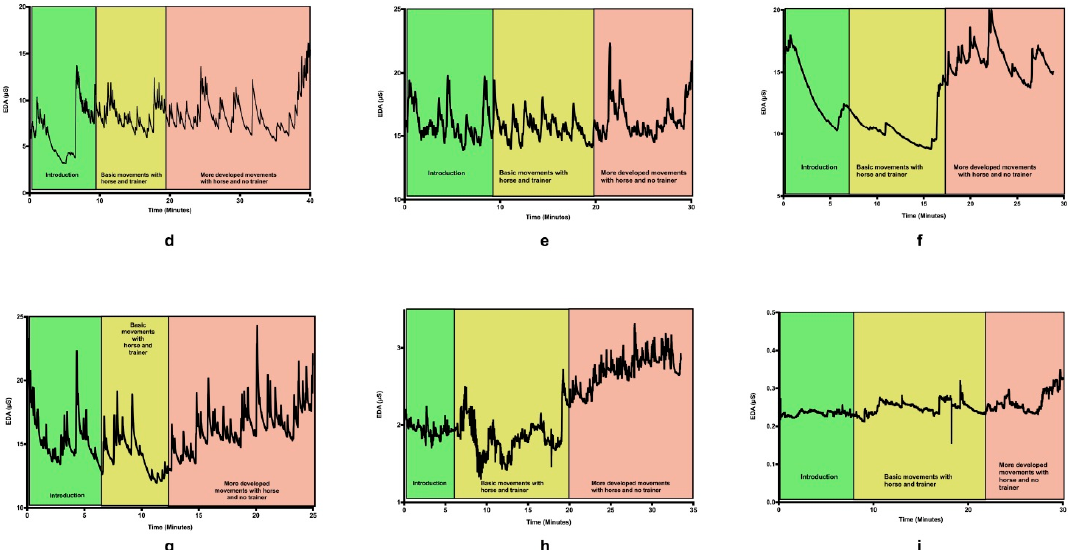
Figure 1. ( a ) Participant 1 SCR (skin conductivity responses), ( b ) Participant SCR, ( c ) Participant 3 SCR, ( d ) Participant 4 SCR, ( e ) Participant 5 SCR, ( f ) Participant 6 SCR, ( g ) Participant 7 SCR, ( h ) Participant 8 SCR, ( i ) Participant 9 SCR.